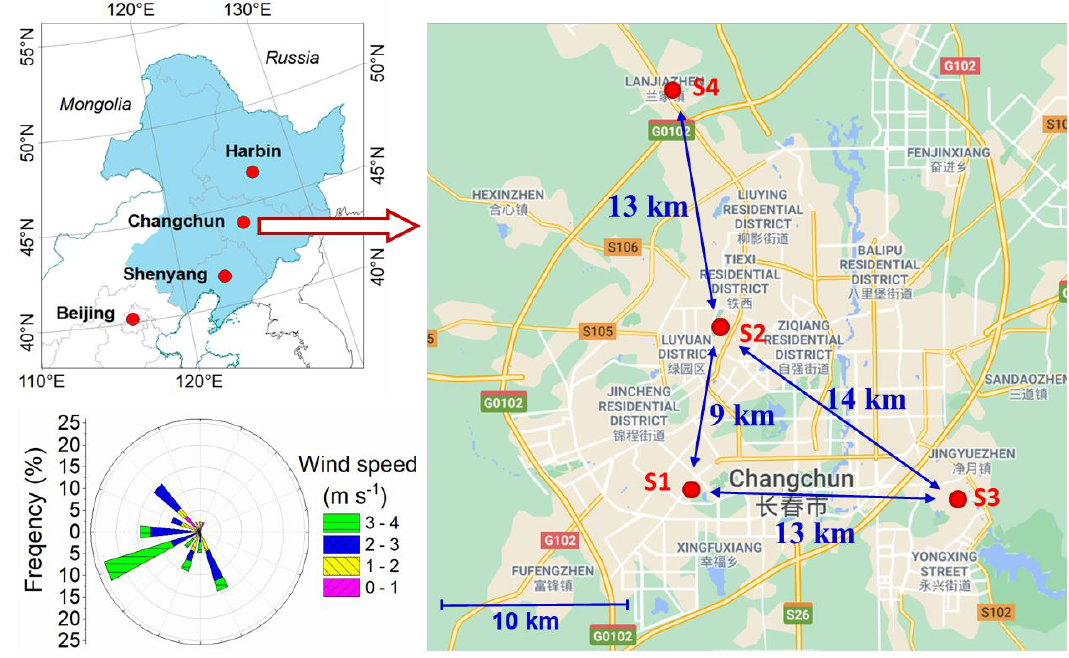
Figure 1. Schematic map of the study sites in Changchun city, Jilin Province, China. Detail information on meteorology and possible emission sources of the sites seen at Table 1. Blue color shaded area in the left upper panel indicates the area of Northeastern China, and the left lower panel is the wind rose map during the study period. The distances between the sites are also indicated.